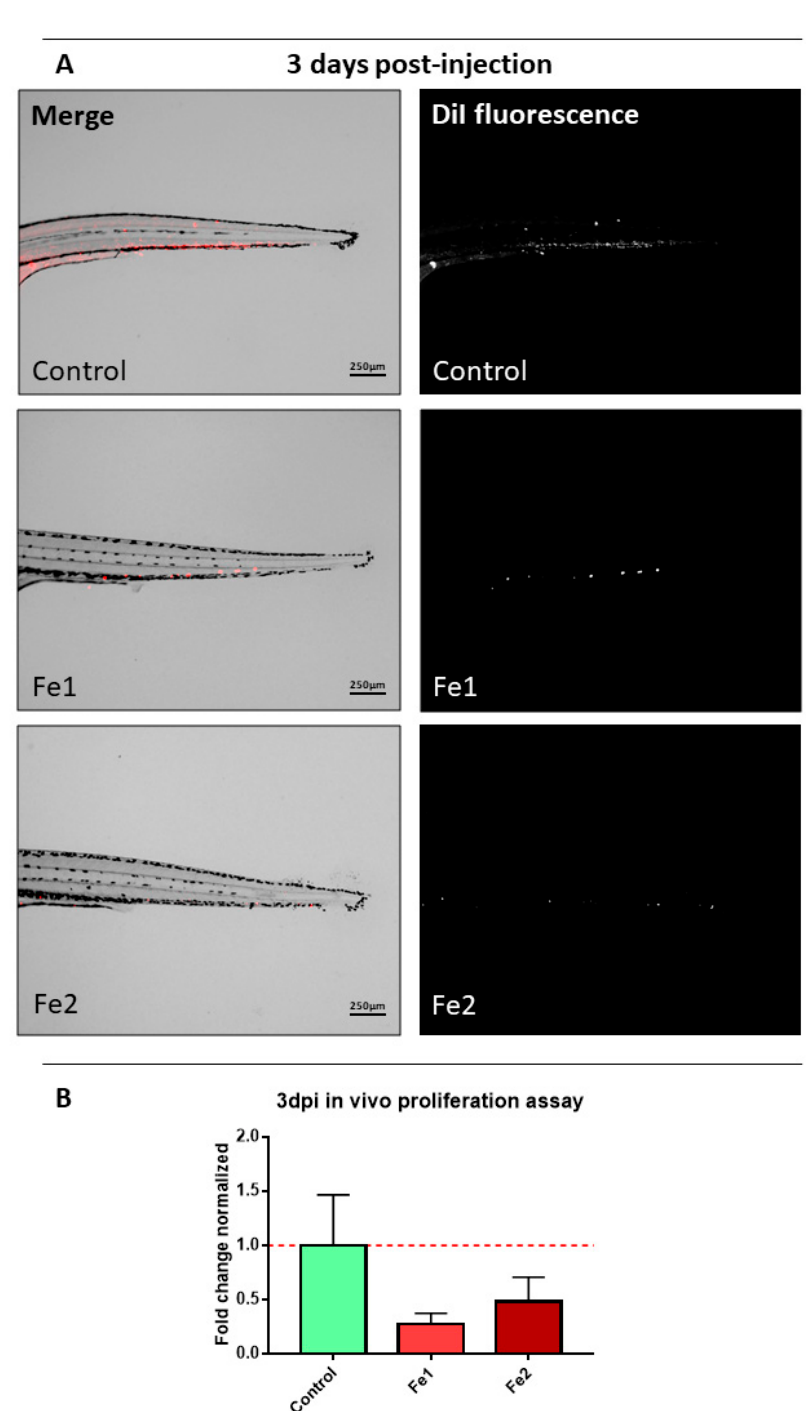
Figure 8. In vivo effectivity assays of Fe1 and Fe2 against human HCT116 colorectal cancer cell line: ( A ) Representative images of the caudal hematopoietic tissue (CHT) in the tail region of the zebrafish embryos where cells metastasize and proliferate at 3 dpi. Main images are a superposition of a fluorescence image and a bright field image of the same embryo. Fluorescence images show only the labelled cells of the main image. Scale = 250 μ m; ( B ) fold change comparing 3 dpi against 1 dpi and normalised to the control condition at 3 dpi. The red line state the cell maintenance, above the bar, proliferation occurs, and below the bar, the cells decrease, compared to the control condition (n = 6 embryos/condition).